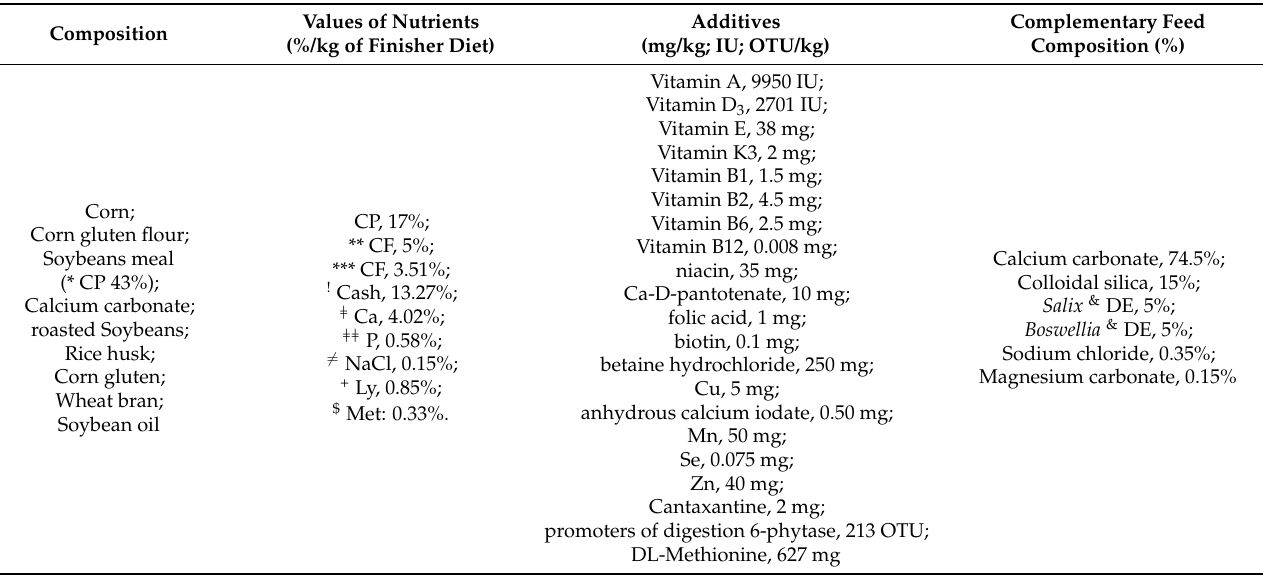
Table 1. Cargill s.r.l. feed formulation based on only the indications of the commercial tag and complementary feed